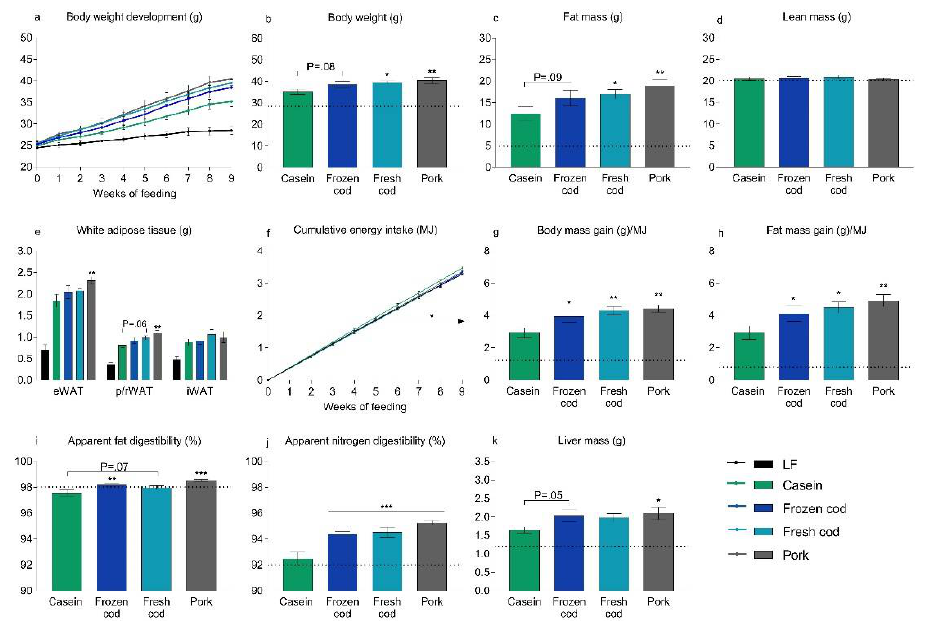
Figure 1. Effects of Western diets with different protein sources on body composition, energy intake and tissue weights. Male C57BL/6J mice were fed Western diets containing casein, frozen cod, fresh cod or pork as protein sources for 12 weeks. As a reference, a group of low fat (LF)-fed mice ( n = 5) was also included and is shown as a dotted line. ( a ) Body weight development was measured and is shown for the first 9 weeks of feeding. ( b ) Body weight was measured and ( c ) fat mass and ( d ) lean mass were determined using nuclear magnetic resonance after 9 weeks of feeding. ( e ) Epididymal white adipose tissue (eWAT), inguinal white adipose tissue (iWAT) and perirenal/retroperitoneal white adipose tissue (p/r WAT) were dissected out after 12 weeks of feeding, and their masses were recorded; ( f ) Feed intake was recorded continuously, and cumulative energy intake (MJ) was determined and is shown for the first 9 weeks of feeding. The arrow indicates a significantly ( p < 0.05) decreased energy intake in mice fed frozen cod and fresh cod compared to mice fed casein. ( g ) After 9 weeks of feeding, body mass gained per energy unit consumed and ( h ) fat mass gained per energy unit consumed were calculated; Apparent ( i ) fat and ( j ) nitrogen digestibility (%) were calculated based on feed intake and feces collected in the 6th week of feeding. ( k ) Livers were dissected out and weighed after 12 weeks of feeding. Data are presented as means ± SEMs ( n = 10) and were analyzed using one-way ANOVA followed by Fisher’s LSD post hoc tests. Cumulative energy intake was analyzed by repeated measures ANOVA and Fisher’s LSD post hoc tests. *, ** and *** represent significant different from the Western diet containing casein at p < 0.05, p < 0.01 and p < 0.001 levels, respectively.